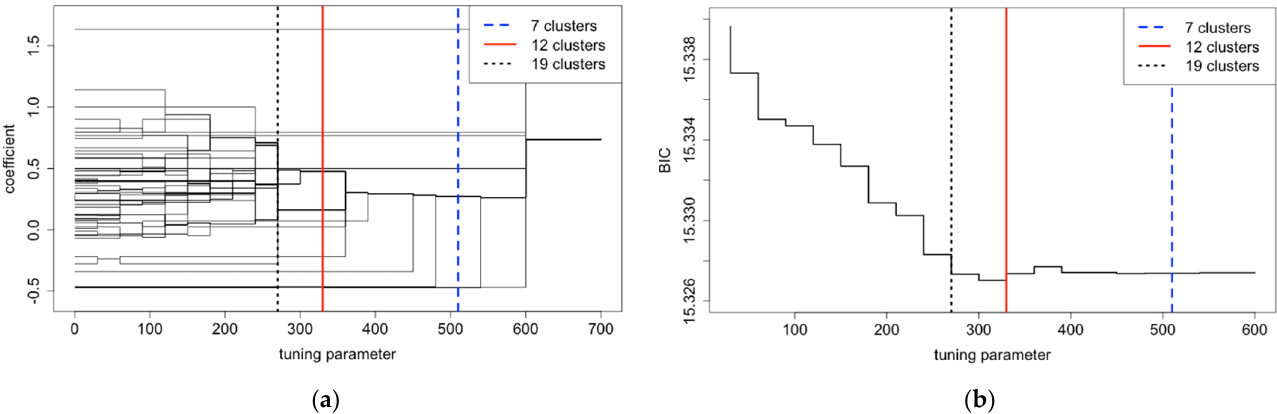
Figure 7. Path of coefficients ( a ) and BIC plot ( b ) with respect to tuning parameter 𝜆 (cid:2870) . The coefficients are clustered into twelve groups. The largest group consists of 27 sites, which are located in southeastern coastal line of South Korea. The estimated trend coefficient of the group is about 0.47, such that the increasing trend of extreme rainfall